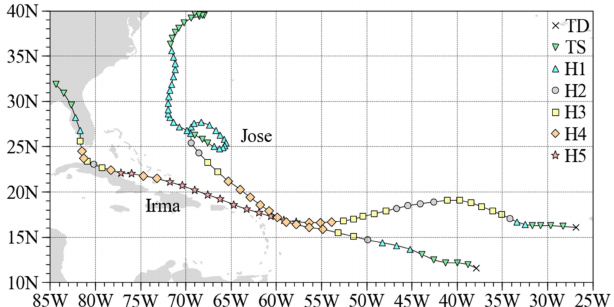
Figure 1. Best tracks (colored markers) of Hurricane Irma from 0000 UTC August 30 to 0000 UTC September 12, 2017 and Jose from 0600 UTC September 5 to 1200 UTC September 22, 2017. Intensity categories (colored markers) are shown in the